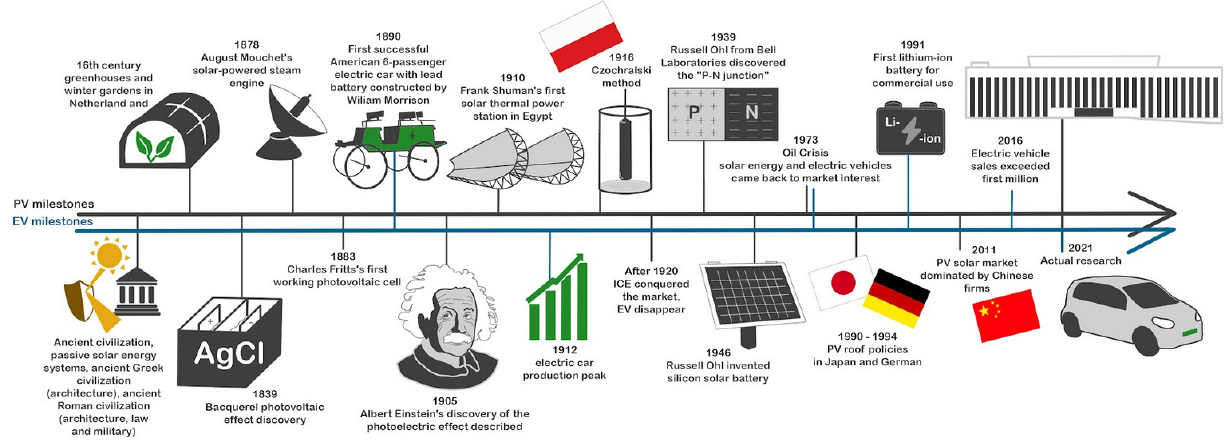
Figure 1. Timeline of analyzed aspects (own work based on